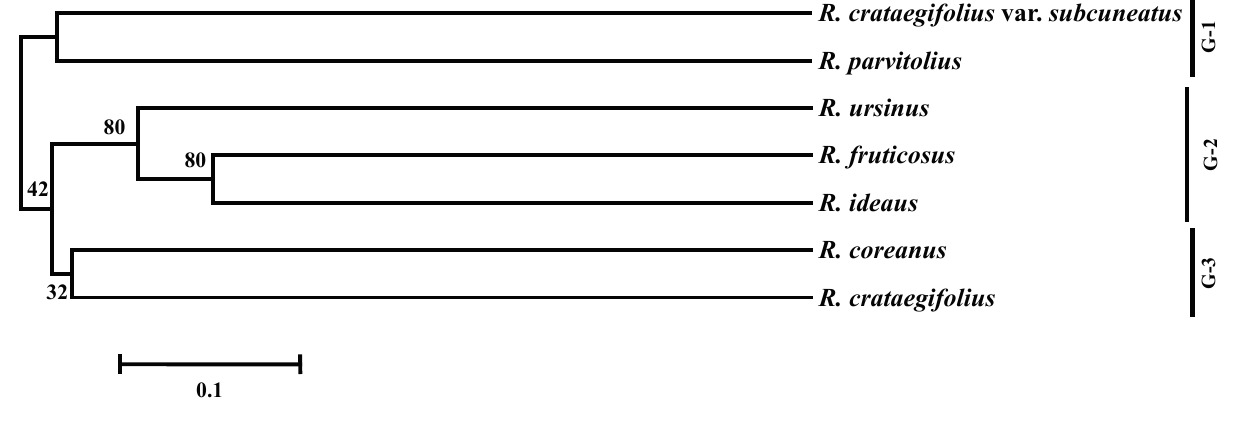
Figure 1. Phylogentic dendrogram based on SSR profiles in Rubus